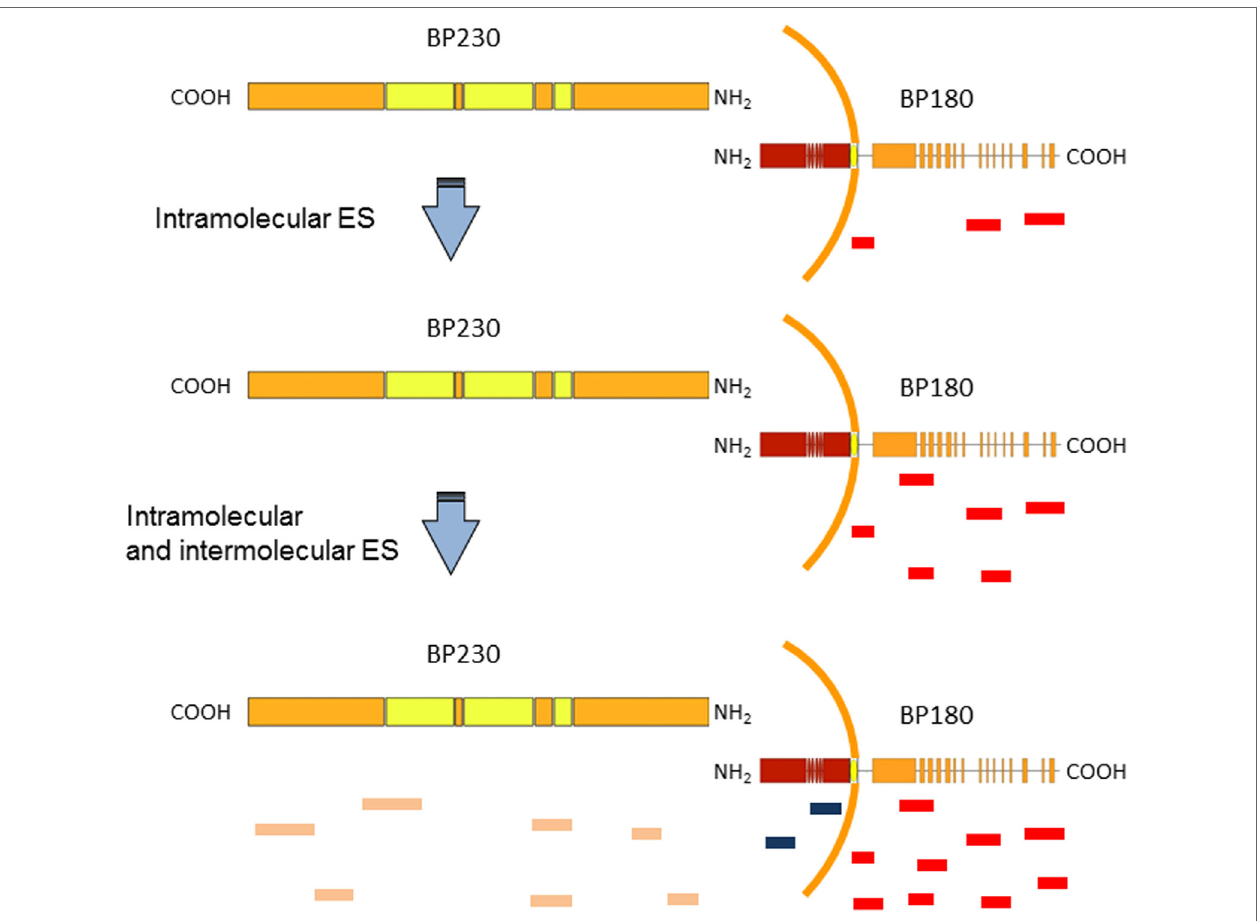
FiGURe 1 | Epitope spreading (ES) in bullous pemphigoid (BP) patients. A schematic representation of BP antigens (BP180 and BP230). Findings support the idea that IgG recognition of the BP180 ectodomain is an early event in BP disease, followed by variable intramolecular ES (red and blue lines in BP180 ectodomain) and intermolecular ES events (orange lines), which likely shape the individual course of BP (22,